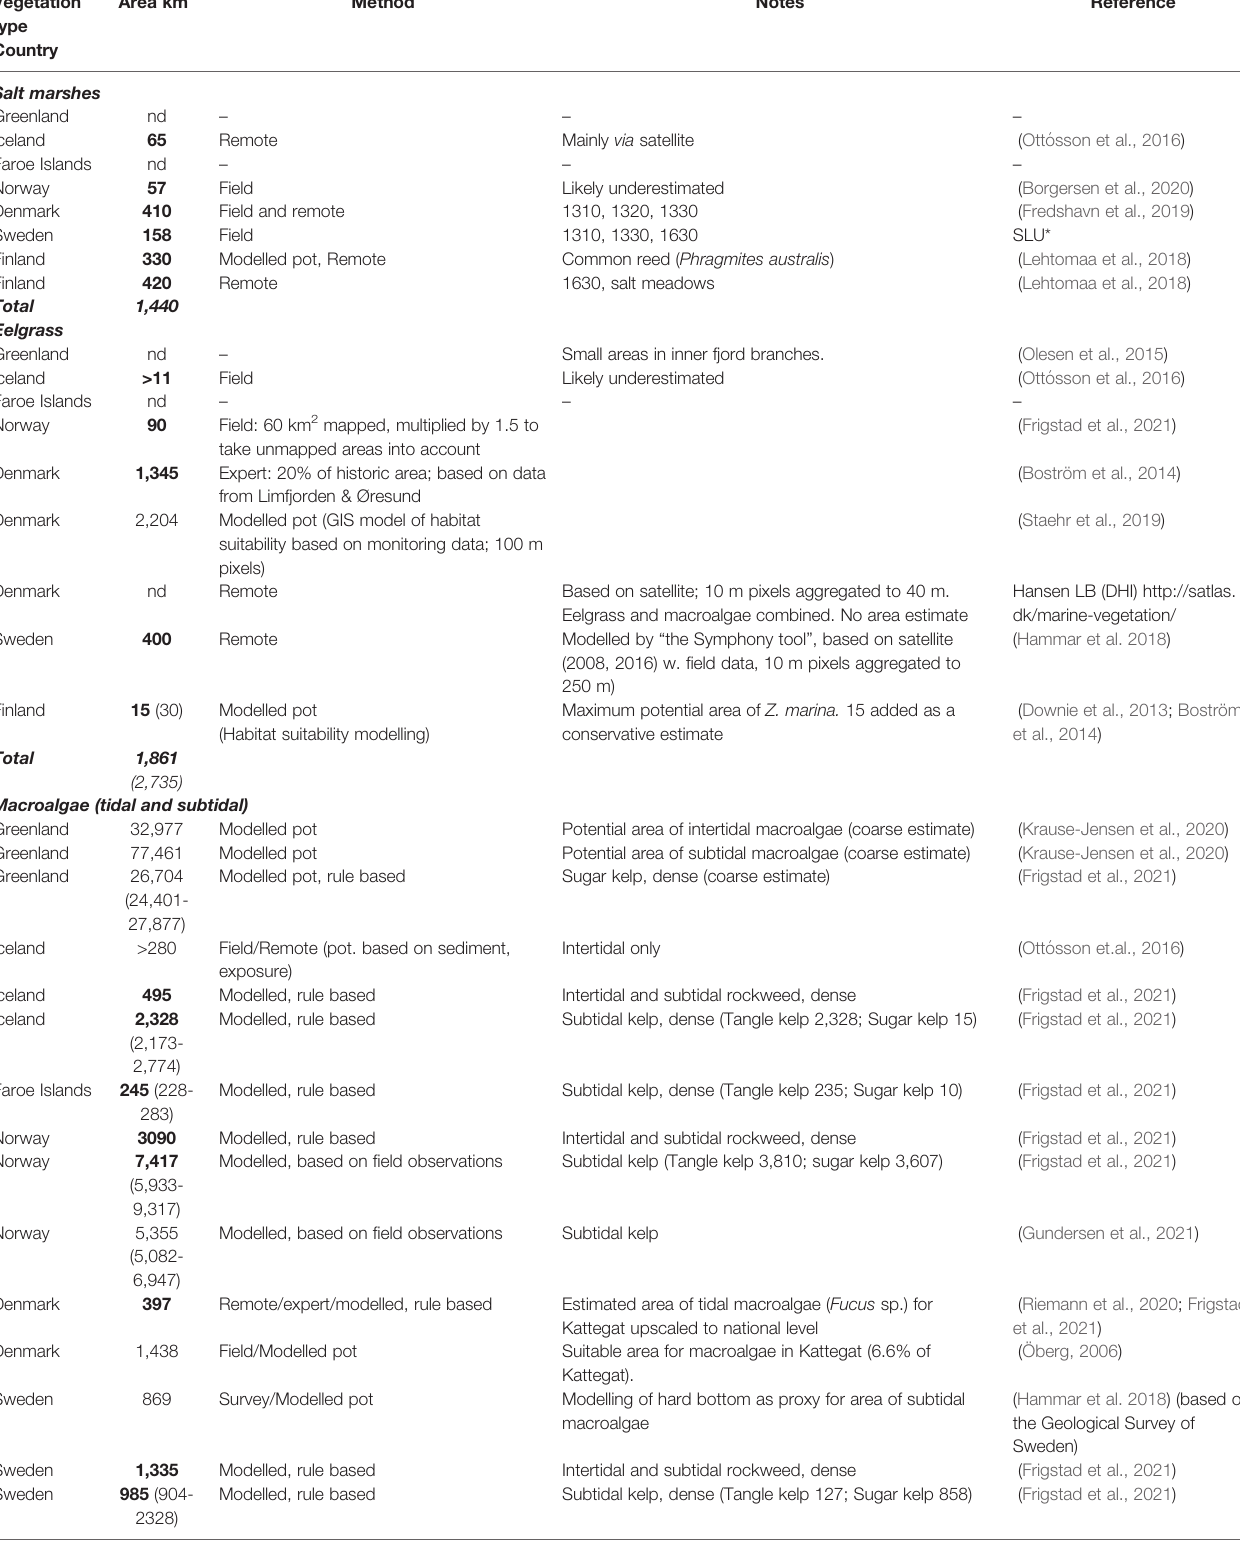
TABLE 1 | Area estimates (km 2 ) of coastal vegetated habitats (salt marshes, eelgrass and other rooted vegetation, macroalgae) across the Nordic region. Vegetation